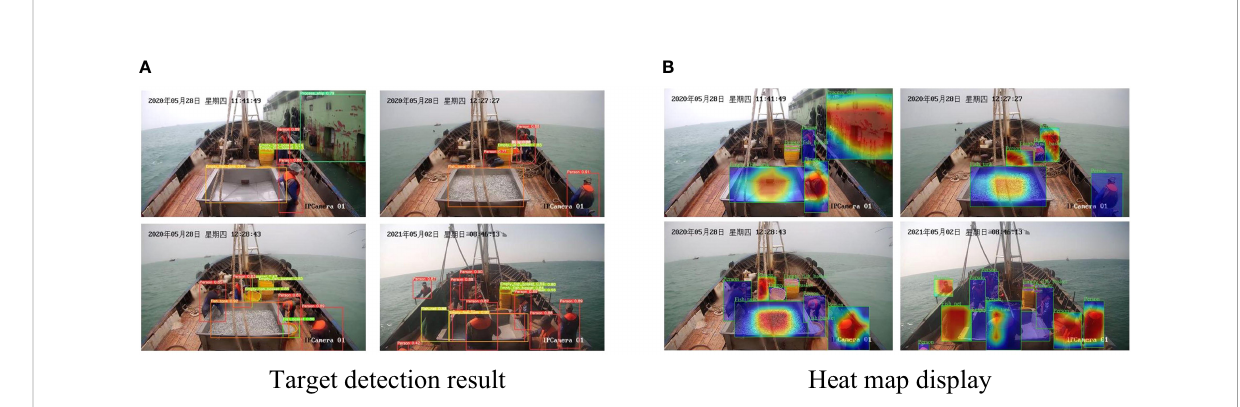
FIGURE 10 The target detection results in the experiment and the related results of the Heat map